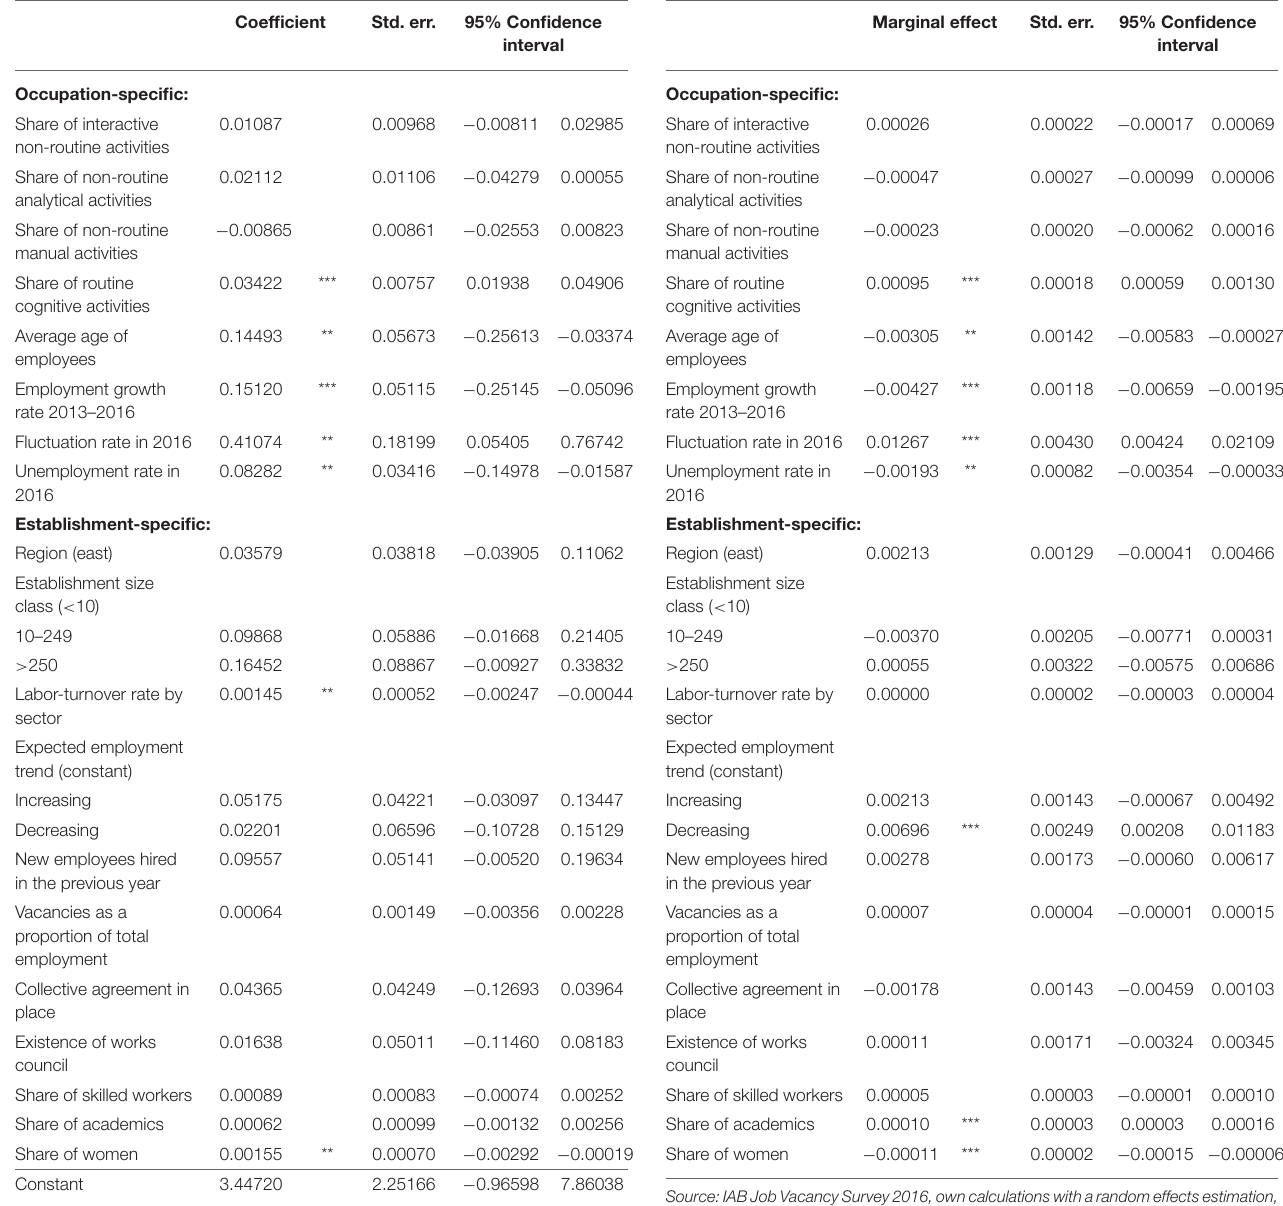
TABLE 7 | Estimation results: increasing requirements regarding self-organization. TABLE 8 | Marginal effects: increasing requirements regarding workplace